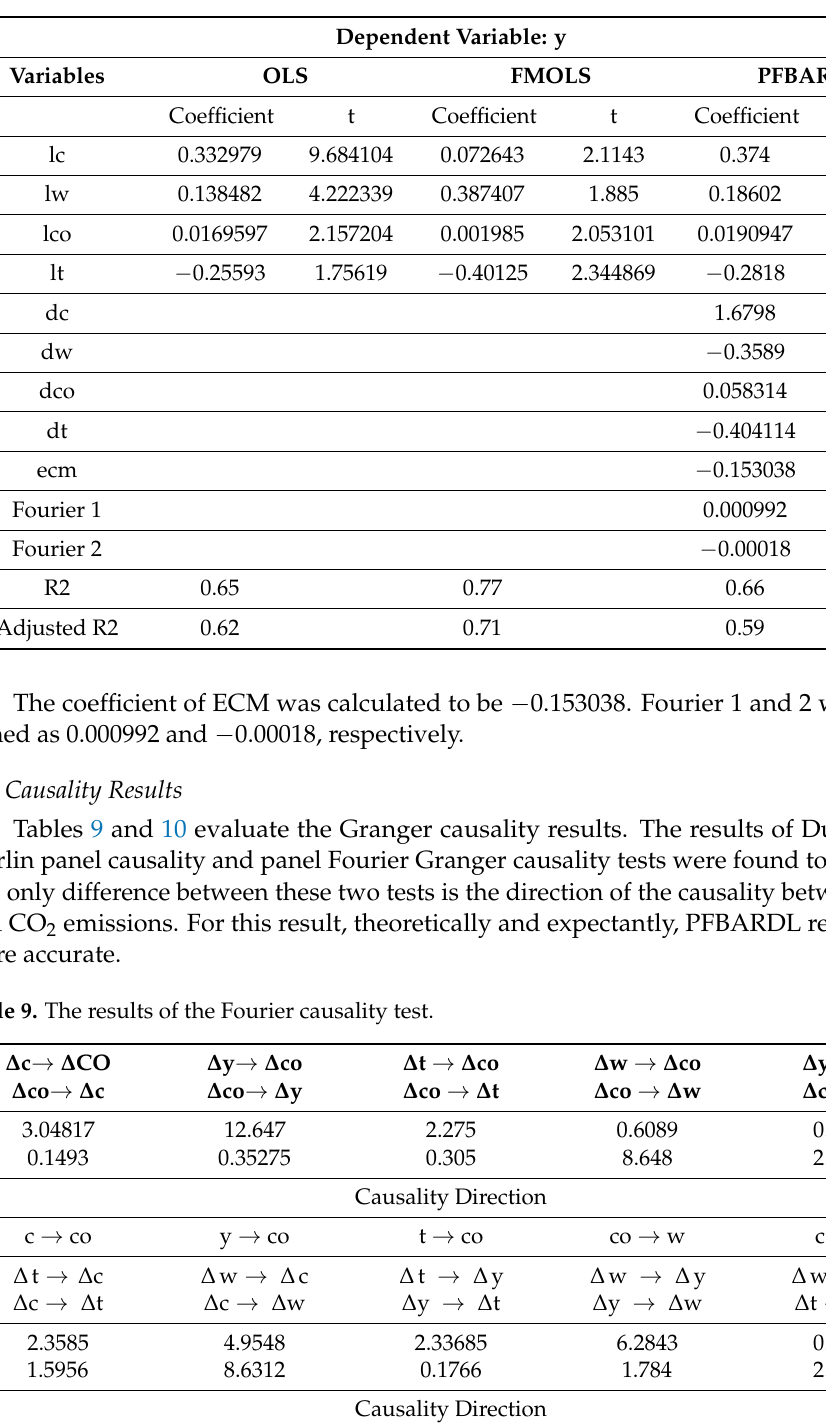
Table 8. FMOLS, DOLS, OLS, and PMG results.